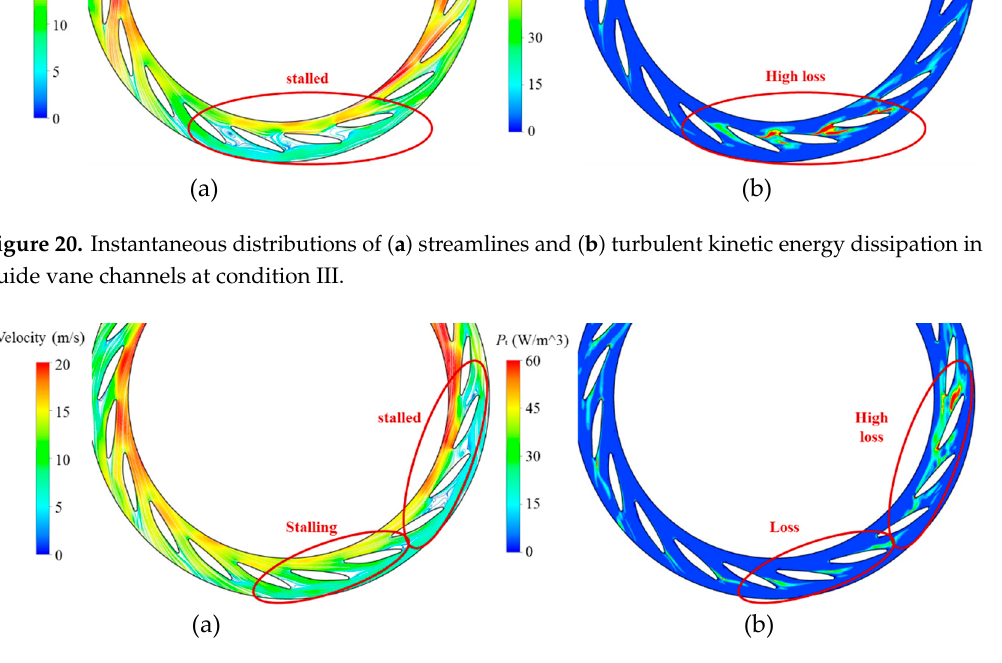
Figure 21. Instantaneous distributions of ( a ) streamlines and ( b ) turbulent kinetic energy dissipation in guide vane channels at condition IV.